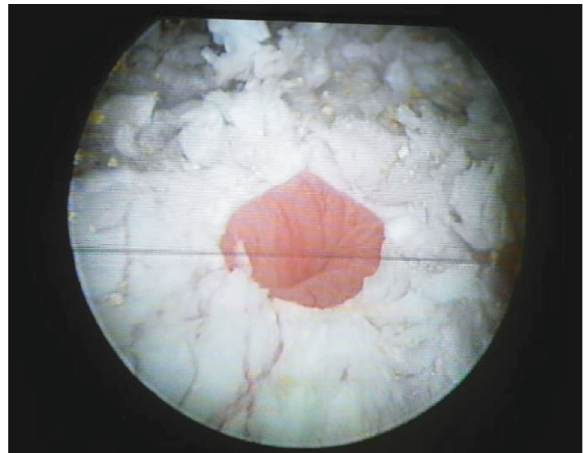
Figure 1: Whitish plaque extended near the left ureteric ori fi ce without interesting it.